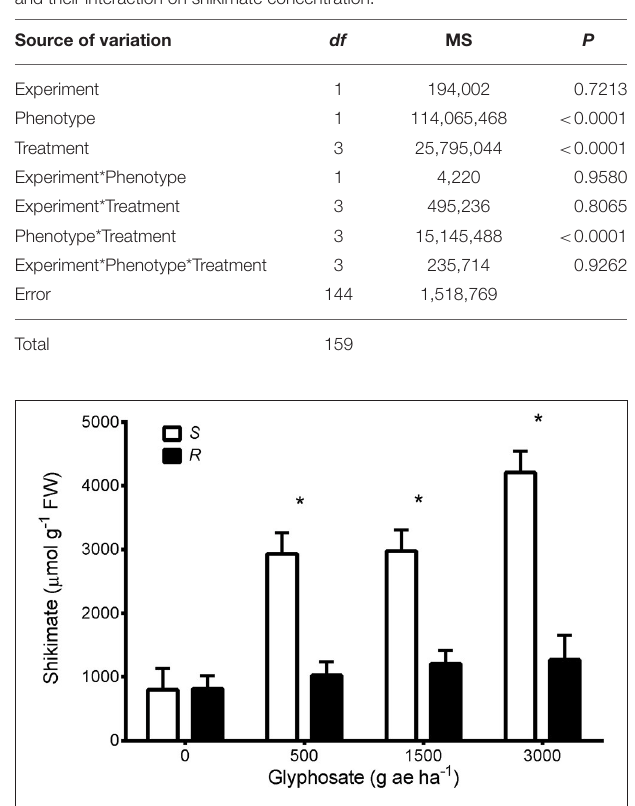
FIGURE 1 | Shikimate accumulation in foliar tissues of glyphosate-susceptible (S) and -resistant phenotypes (R) after glyphosate treatments. Vertical bars represent ± 1 standard error of the mean. Asterisks indicate significant differences between phenotypes within each dose.